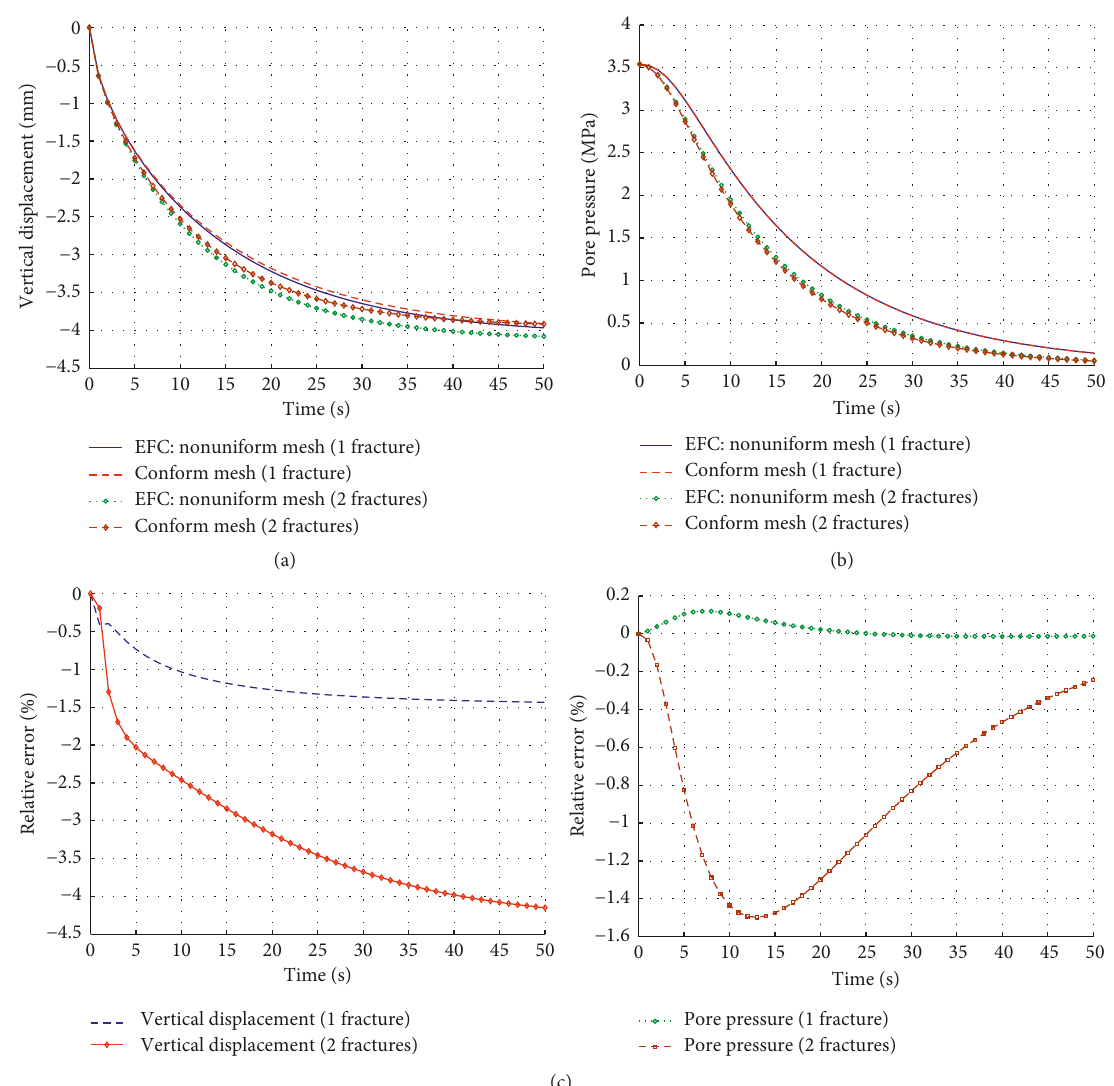
F IGURE 12: Vertical displacement at the controlled point “A” (a), pore pressure at the controlled point “B” calculated from the nonuniform and conformed mesh models (b), and relative error (%) between nonuniform mesh model (c) and conformed mesh model (d).